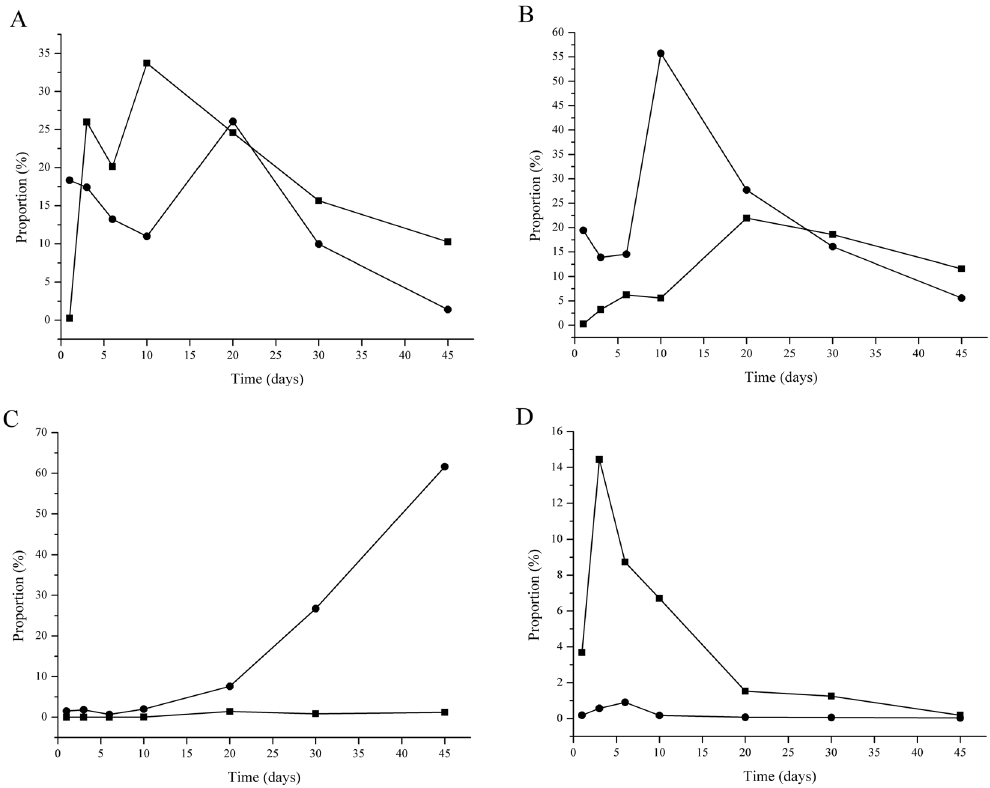
Figure 4. Serial changes of the major four species Lb . plantarum ( A ), Lb . brevis ( B ), Lb . parafarraginis ( C ), and L . lactic ( D ) during ensilage of corn stover inoculated with different LAB inoculants and control treatment. Treatments are inoculated silages ( ● ) and controls ( ■